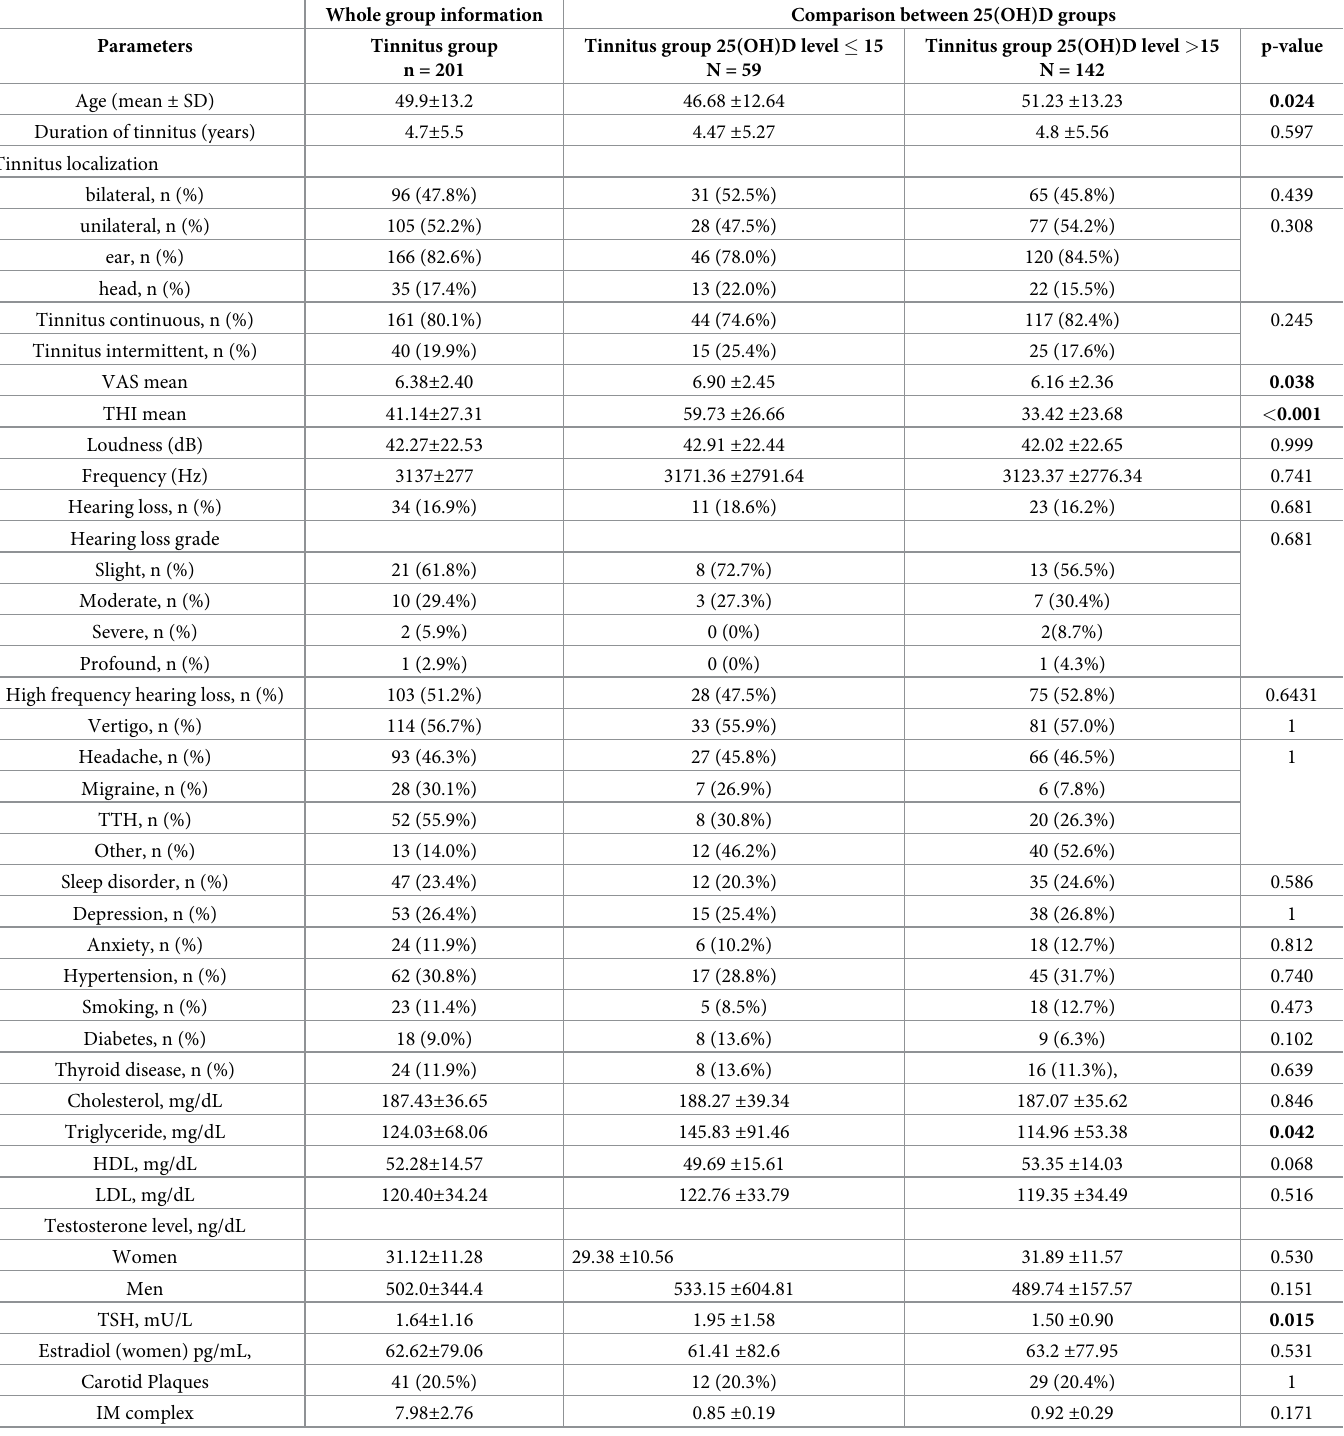
Table 2. Demographic and clinical characteristics of the whole tinnitus group, and depending on 25(OH)D